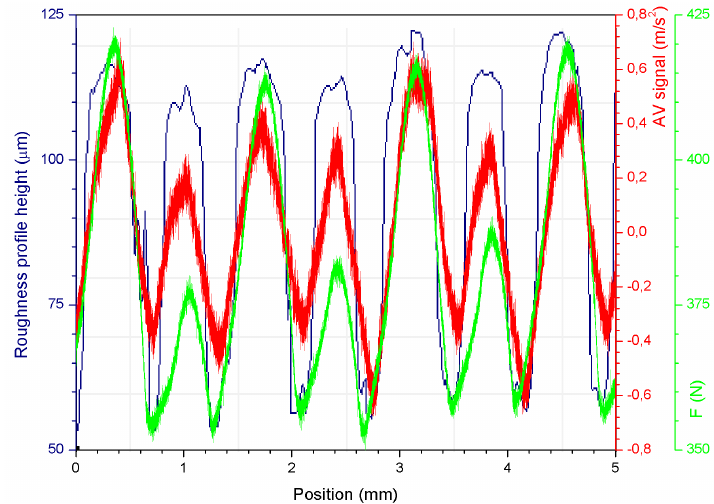
Figure 12. Vibratory signal acquired by the AV accelerometer (red), roughness profile (blue), and burnishing force (green) variation registered during the VABB process—90 mm/min, 400 N, and 5